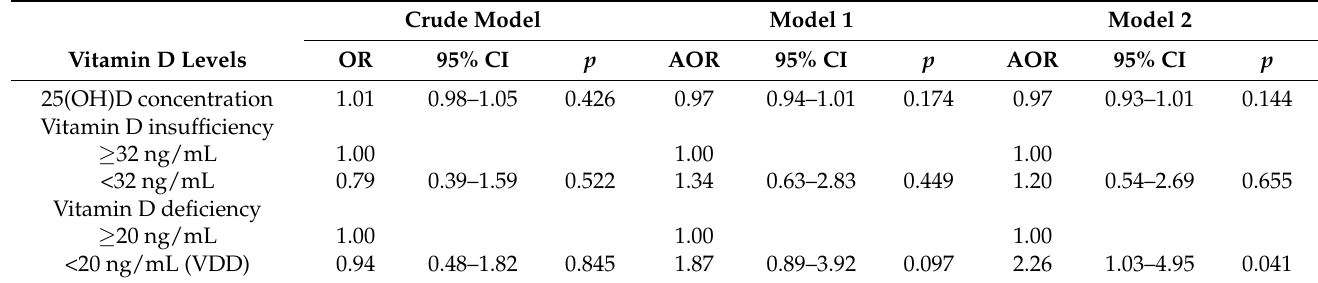
Table 3. Association between vitamin D during pregnancy and gestational diabetes mellitus.